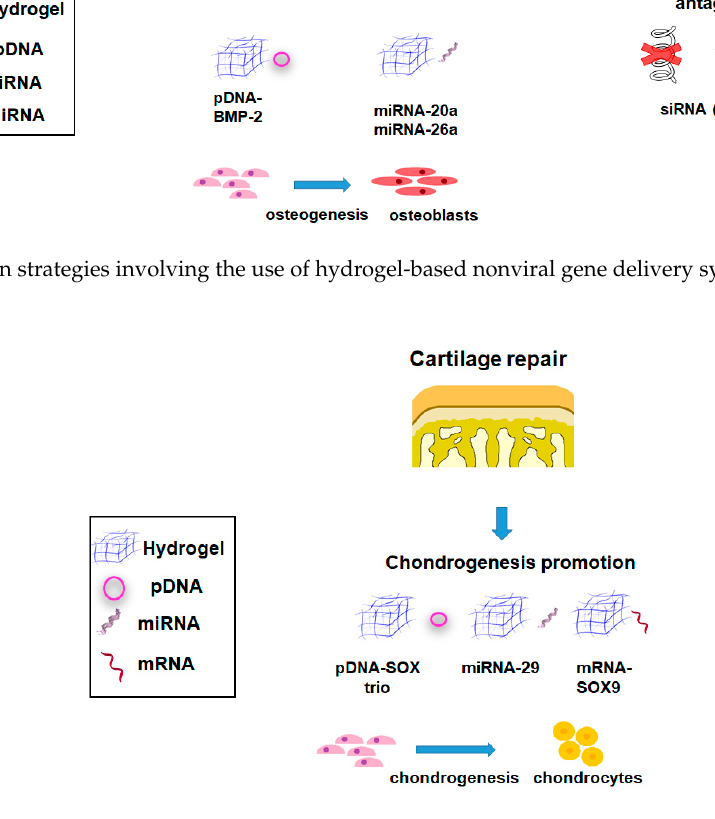
Figure 2. Main strategies involving the use of hydrogel-based nonviral gene delivery systems for cartilage tissue repair.